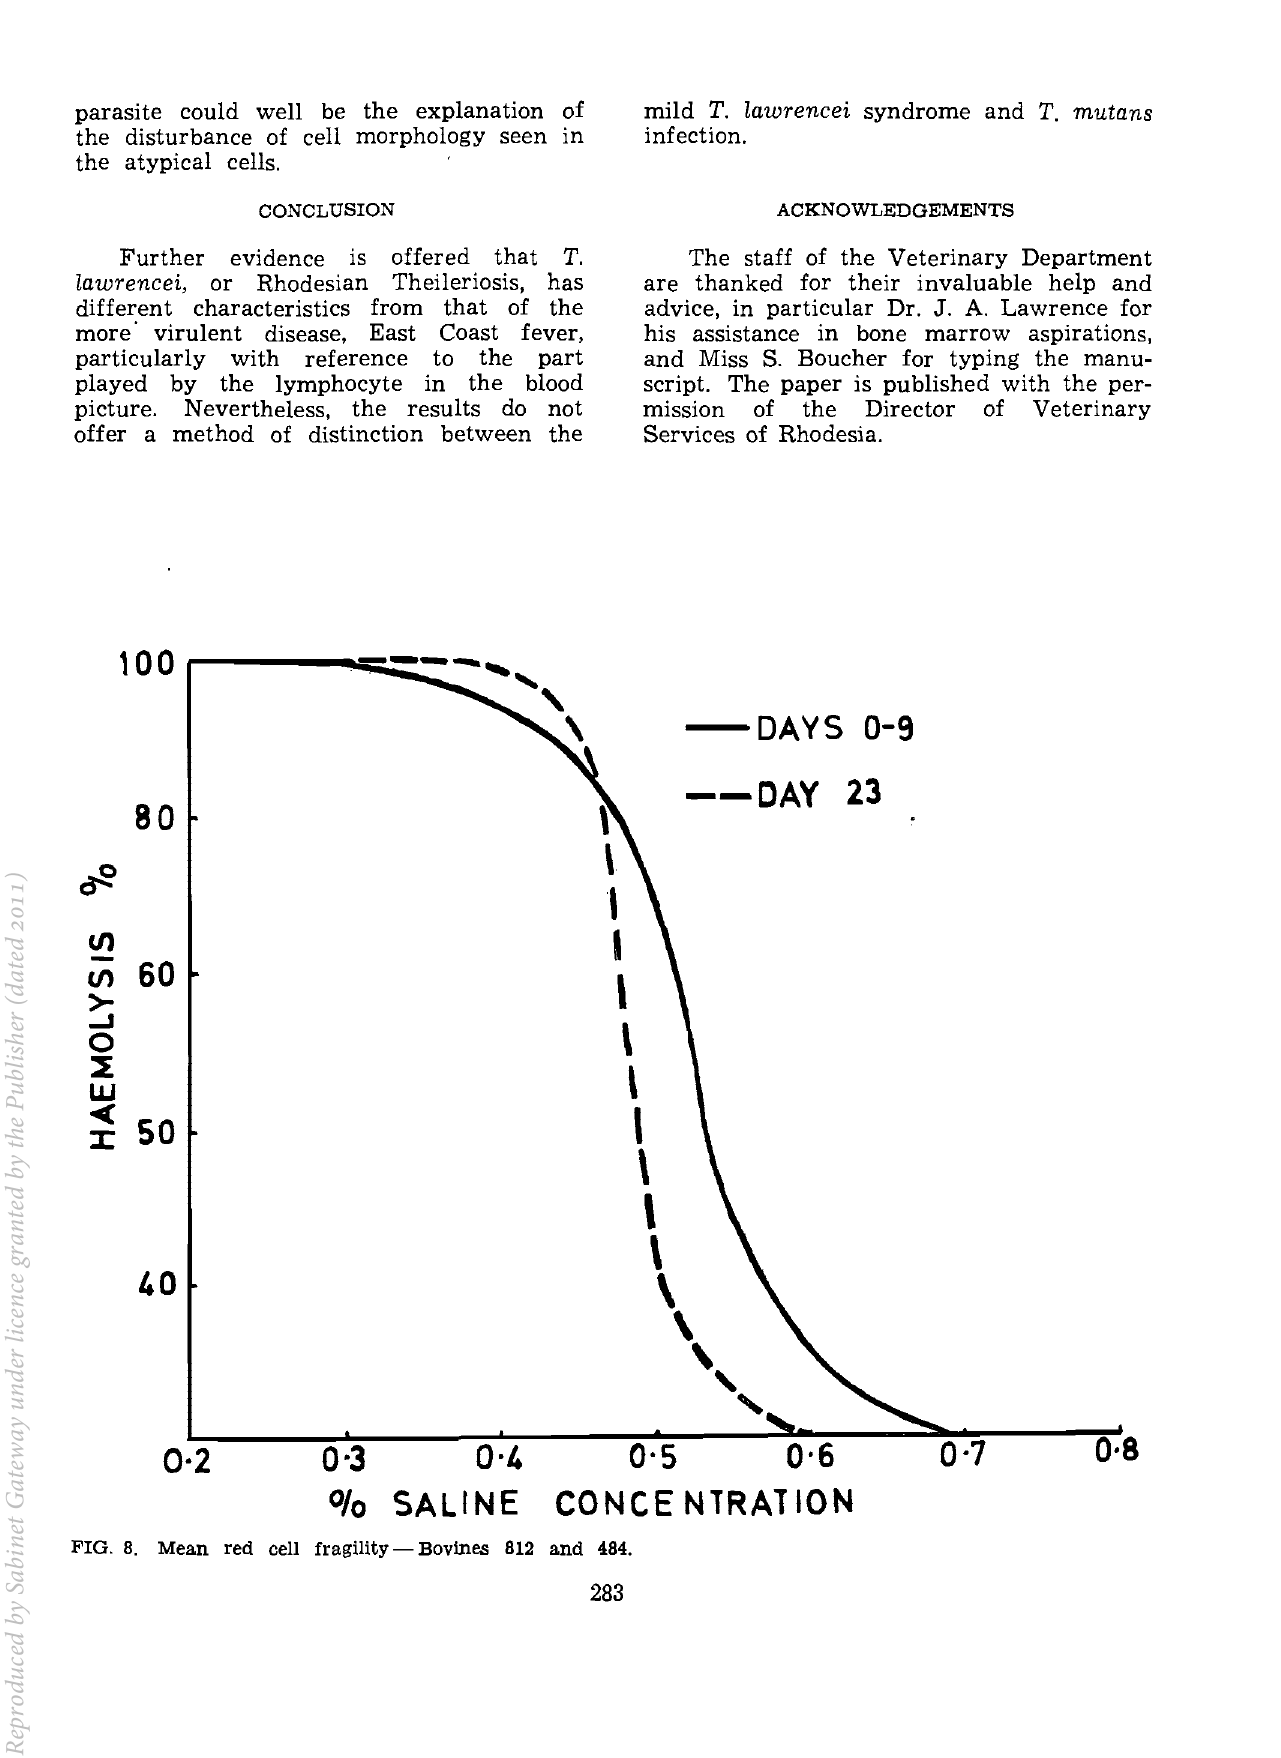
FIG. 8. Mean red cell fragility - Bovines 812 and 484.